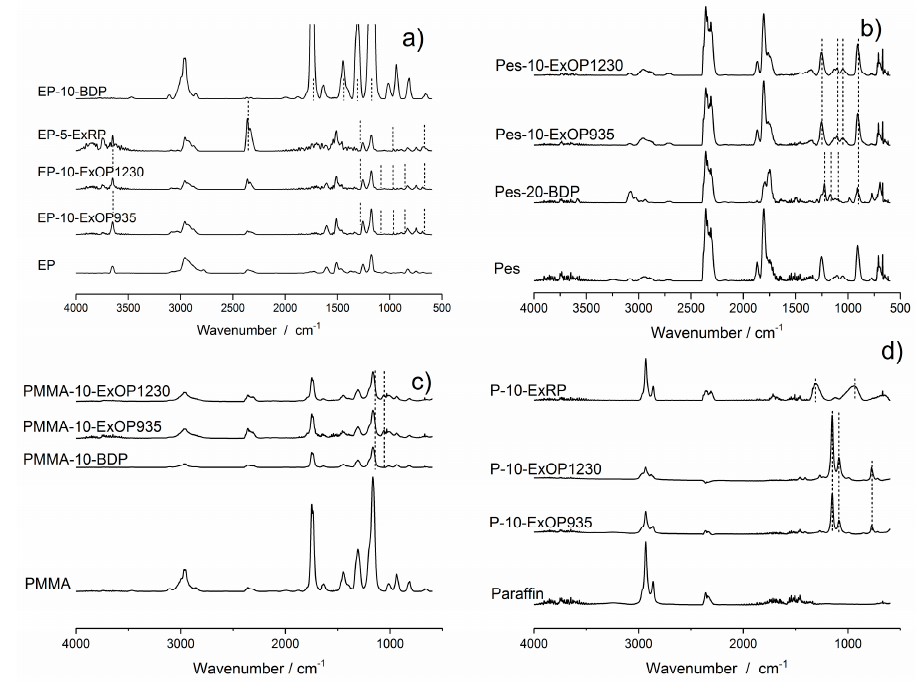
Figure 2. Fourier transform infrared (FTIR) spectra at the respective main decomposition step of flame retardants in: epoxy ( a ); polyester ( b ); PMMA ( c ); and paraffin ( d ) systems. Dotted lines were included as an aid to highlight smaller peaks from phosphorus species.